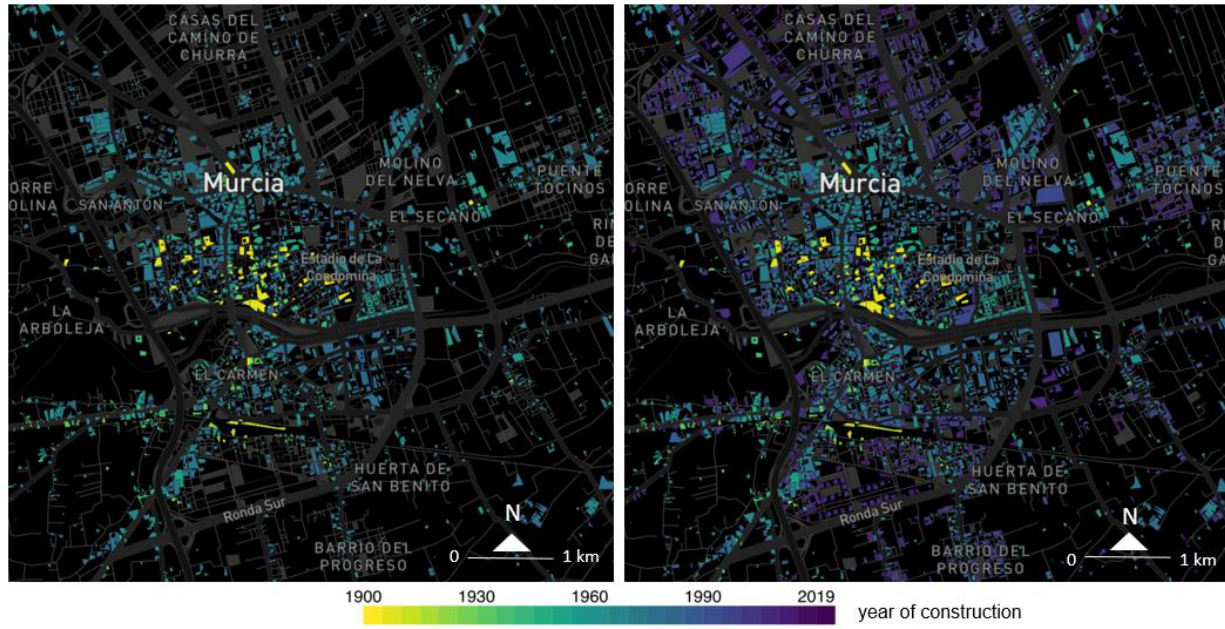
Figure 4. Spatial representation at a city scale of existing buildings by date of construction in the city of Murcia in 1980 ( left ) and 2019 ( right ). Source of data: General Directorate for Cadastre of Spain.